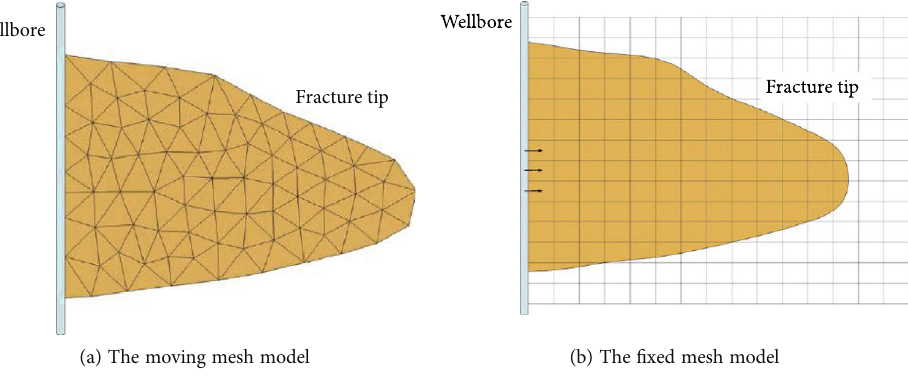
Figure 1: Two kinds of PL3D model system [17]. Table 1: The type of di ff erent formation layers in the tight gas